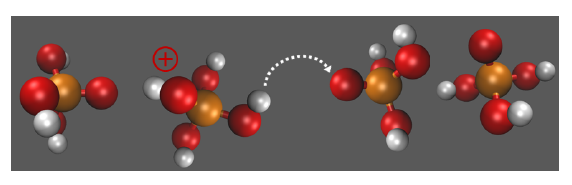
Figure 2: Illustration of the proton conducting mechanisms in phos- phoric acid (Grotthuss mechanism). 'Excess' proton or protonic defect diffuses through the hydrogen bond network of phosphoric acid.